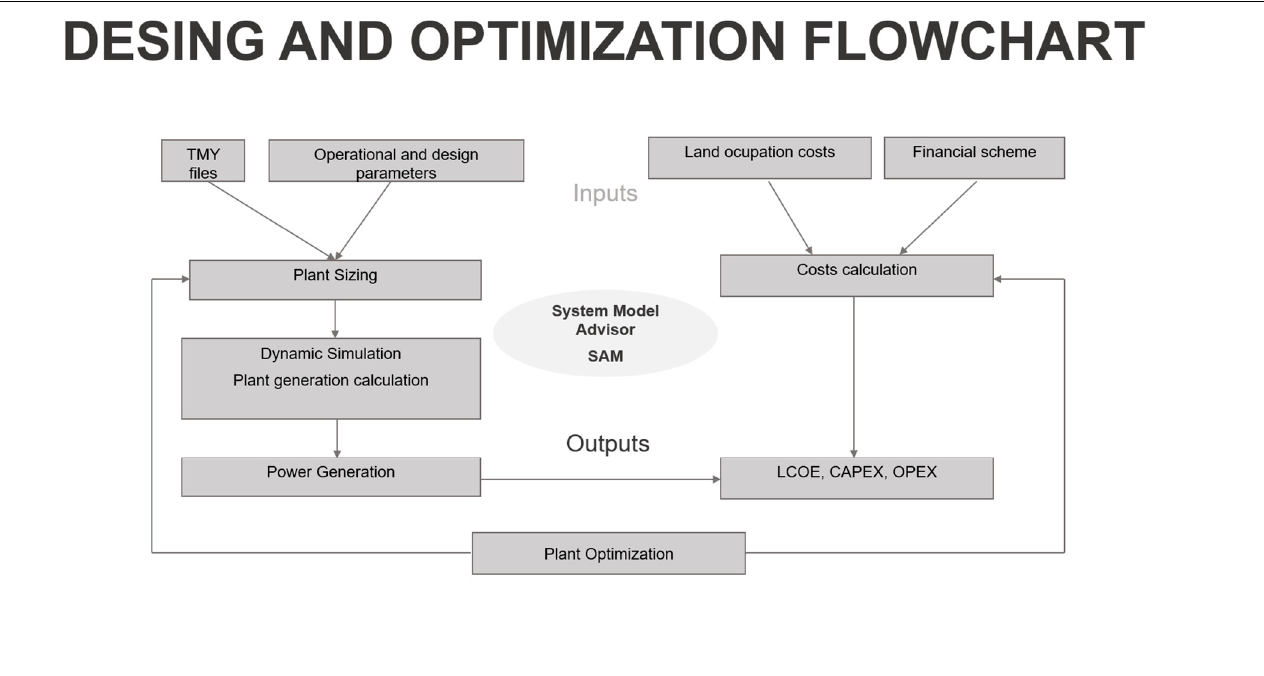
Figure 6. Calculation and optimization flow chart.